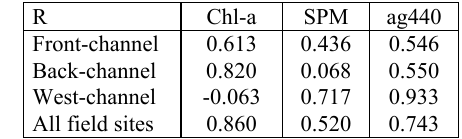
Table 1. Correlation coefficients between COD Mn and water colour constituents in